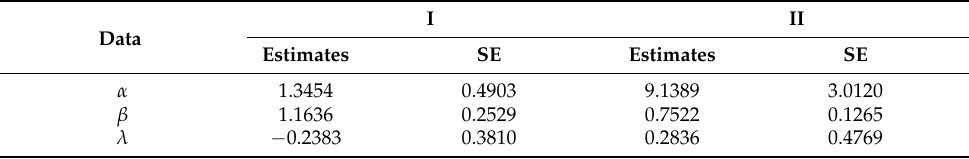
Table 8. Bayesian estimation of TT L LBE model for each data sets.